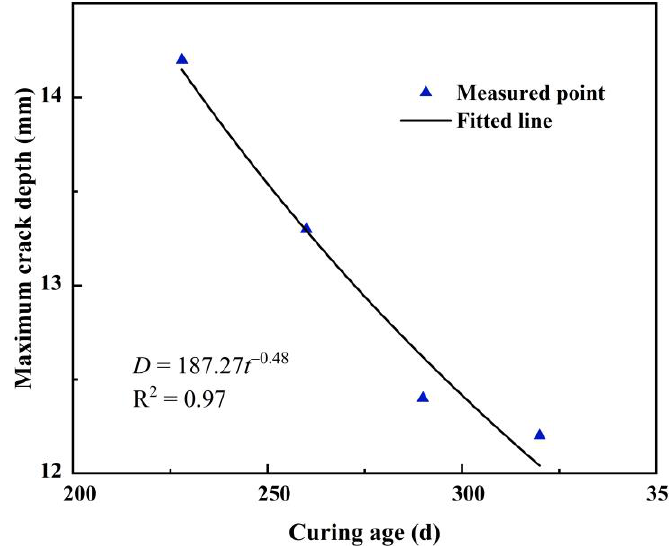
Figure 15. Maximum crack width curve after creep.